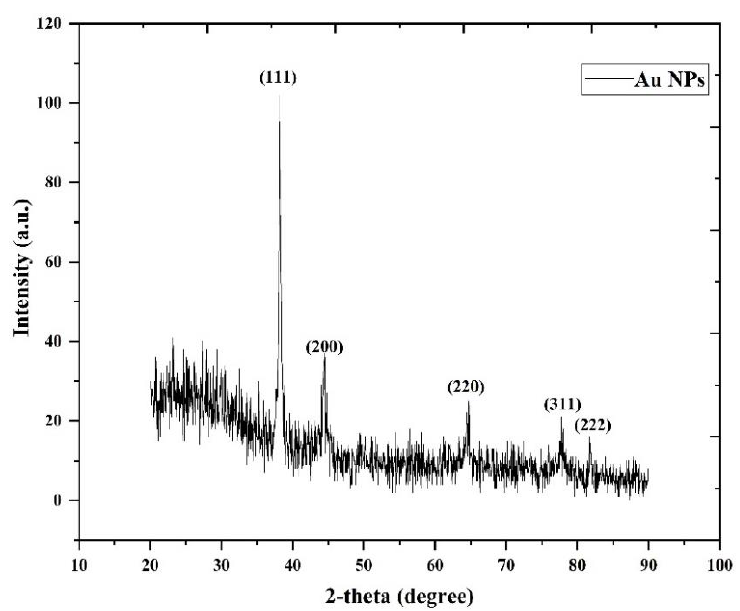
Figure 1. XRD pattern of face-centered cubic (fcc) structure gold nanoparticles (AuNPs).